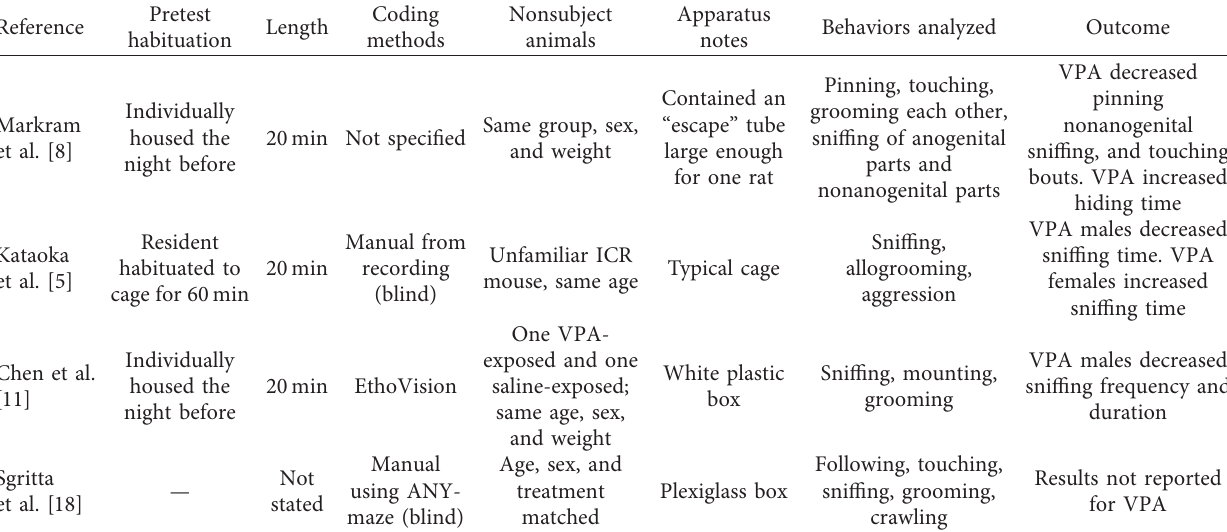
Table 3: Social interaction